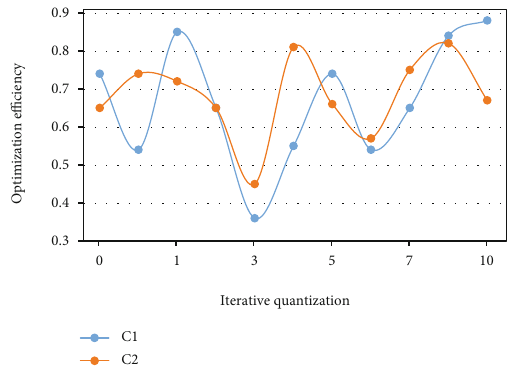
Figure 7: Optimization e ffi ciency analysis